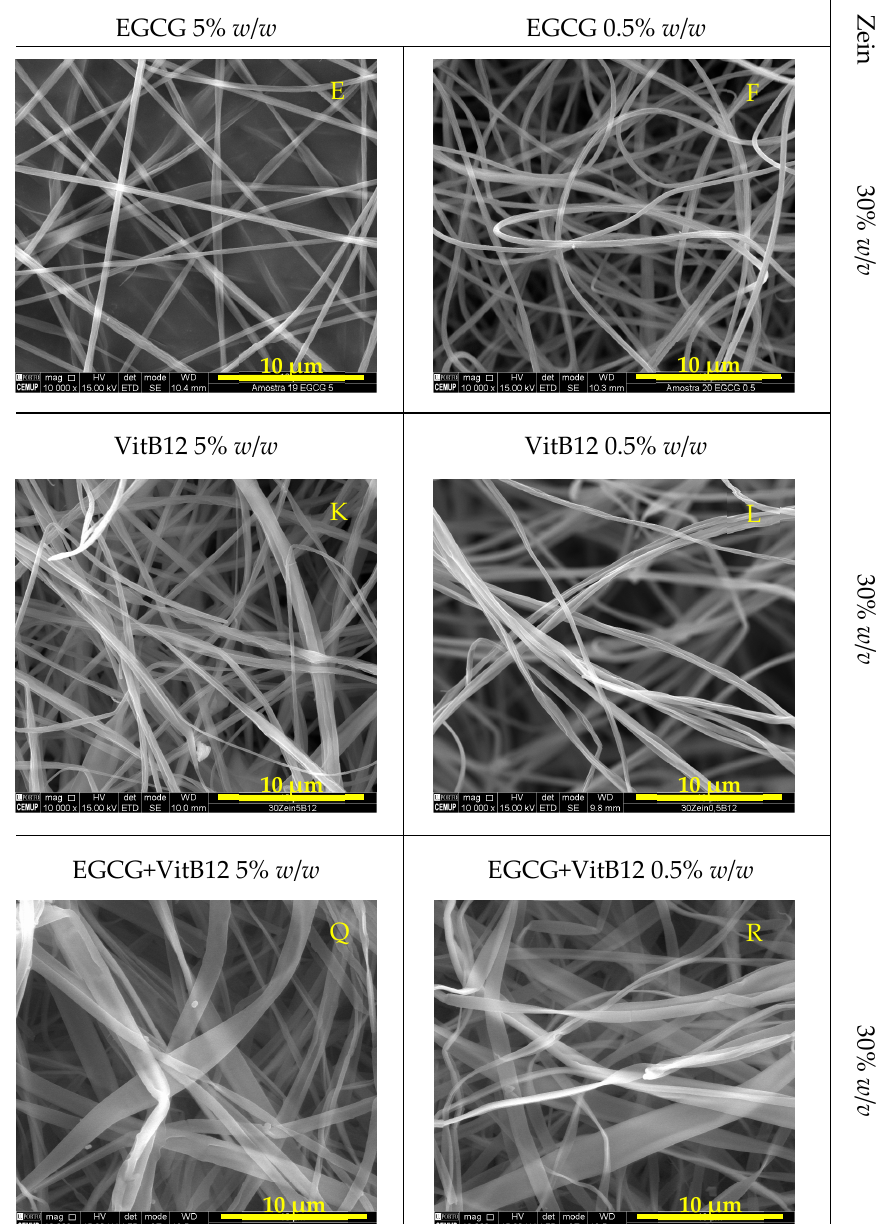
Figure 1. SEM images of microstructures (pump controlled samples) containing different concentrations of zein, EGCG, and VitB12. Magnification of 30,000× for ( A – D , G – J , M – P ) and 10,000× for ( E , F , K , L , Q , R ), beam intensity (HV) 15.00 kV, distance between the sample and the lens (WD) less than 10.6 mm, scale bar of 3 μ m for ( A – D , G – J , M – P ) and 10 μ m for ( E , F , K , L , Q , R ). The diameter of the particles and the width of the fibers were measured using the SEM images. Overall, particles formed with 1%, 5%, and 15% w / v zein have a diameter ranging from 0.2 to 0.8 μ m. No differences in size were observed when compared between the type of the core. The fibers formed with 30% w / v zein have a width between 0.4 and 1 μ m. The largest width is observed in fibers with the mix core, at every core concentration (0.5%, 1% and 5% w / w EGCG + VitB12).